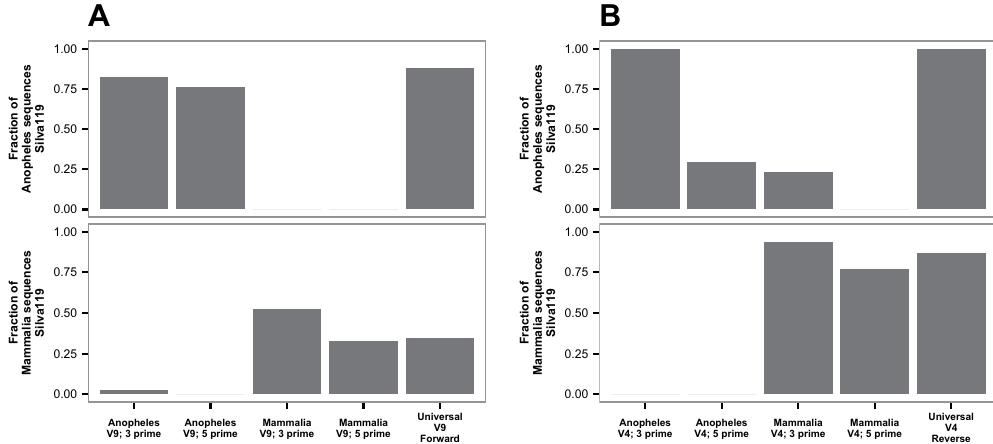
Figure 1. In silico evaluation of target specificity for the annealing blockers of Anopheles and Mammalia . The y-axis represents the relative fraction of 18s rRNA gene sequences present in version 119 of the Silva database that match the primer indicated on the x axis, with match defined as a weighted score < 1.0 (See Methods). ( A ) Specificity for V9 region annealing blockers. ( B ) As in A, but for the V4 region annealing blockers. As positive controls, the reference universal eukaryotic PCR amplification primers V9-Forward and V4-Reverse primers were also queried against the Silva database (right bar in each frame).